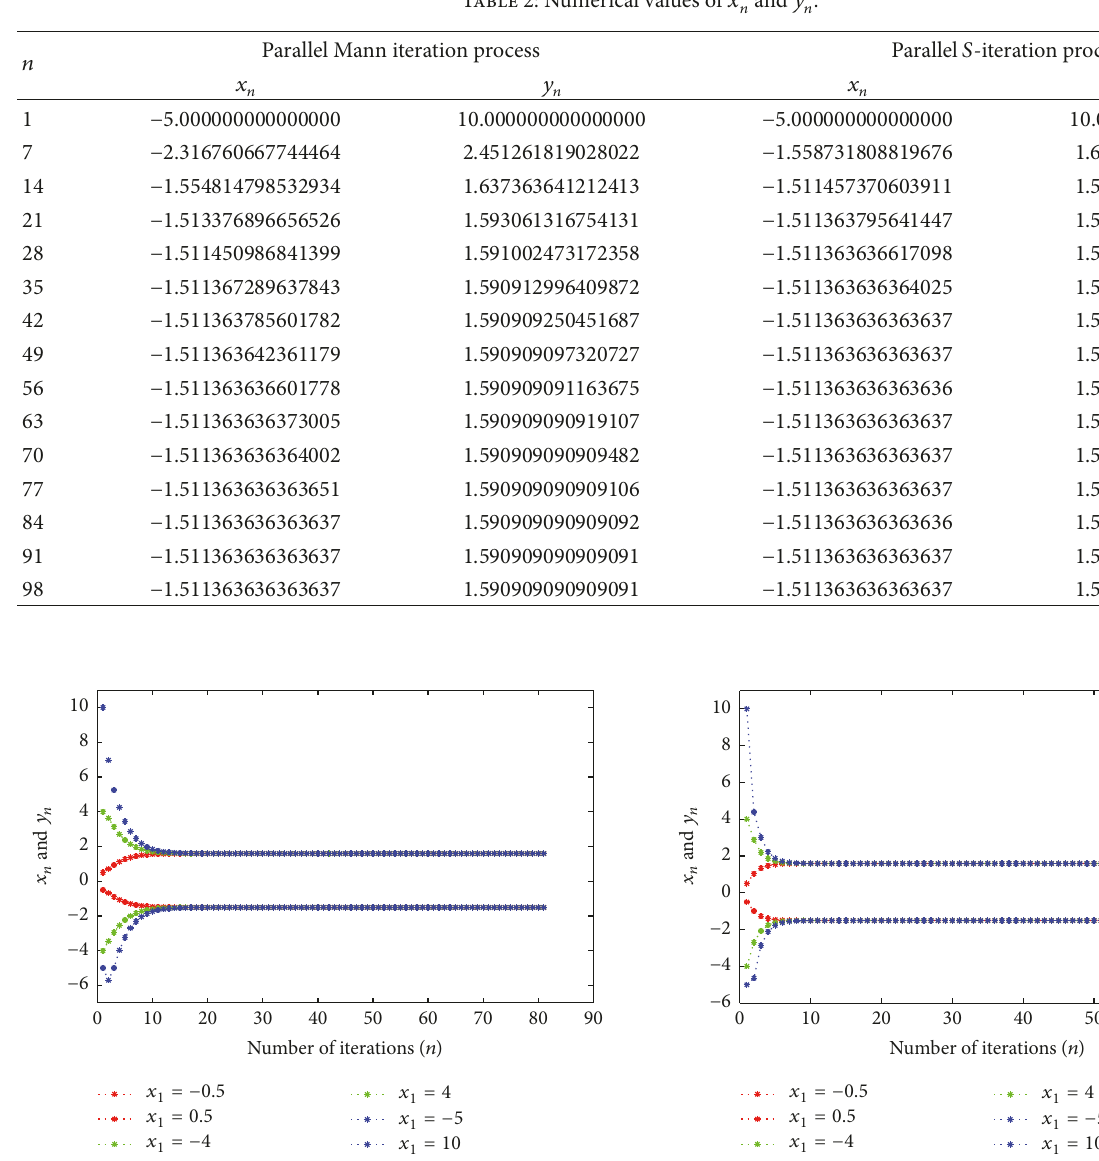
Figure 1: Convergence of sequences {𝑥 𝑛 } and {𝑦 𝑛 } generated by parallel Mann iteration process (32).